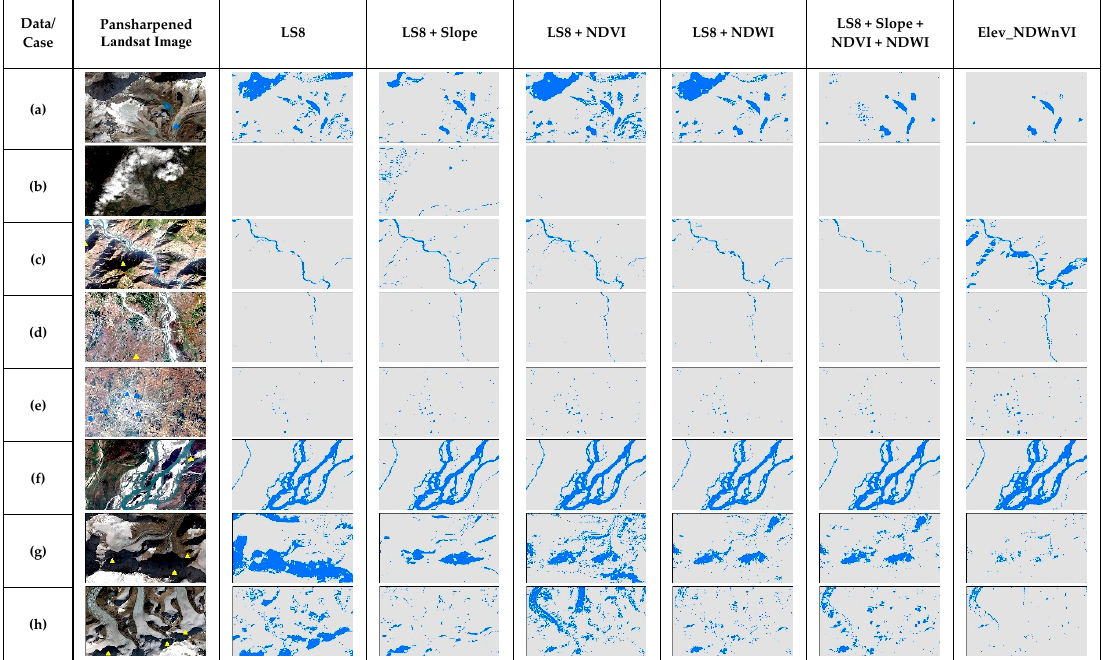
Figure 6. The comparison of NB results of special cases of surface water in the test scene (Figure 1) for different multiband data used.